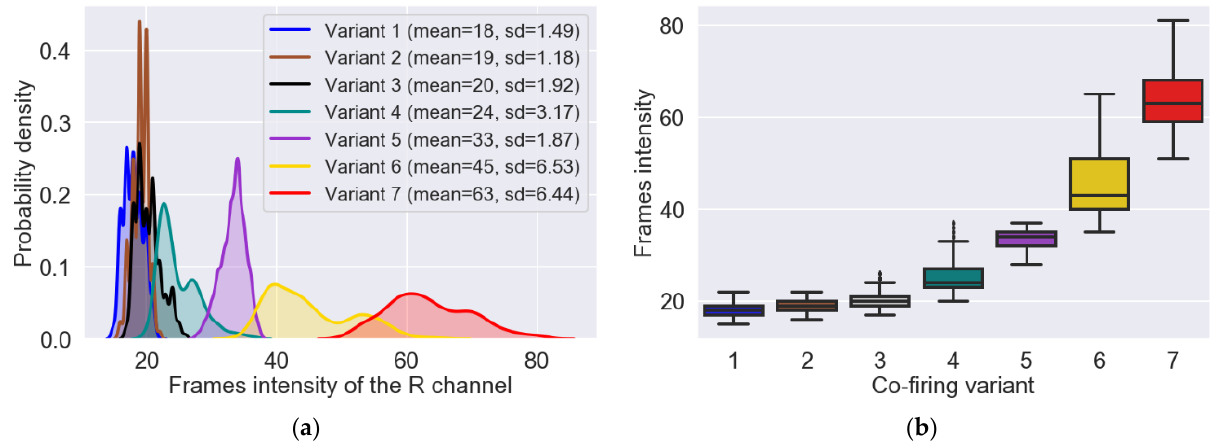
Figure 3. Probability density functions of the frames intensity ( a ) and box plots showing the dispersion of the frames intensity around the median ( b ). The results presented in the graphs were obtained based on the analysis of the entire set of 1676 images for each variant.